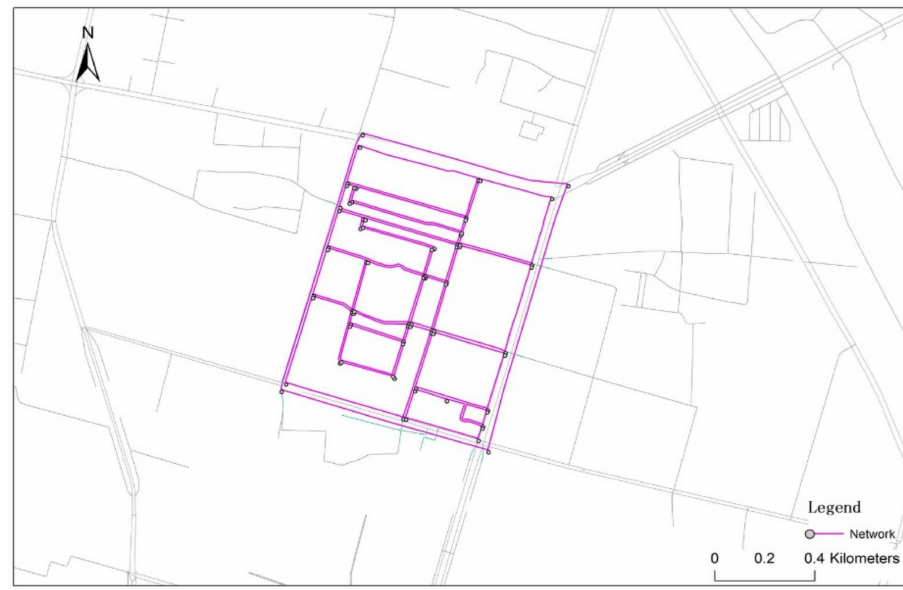
Figure 2. The road network for the study area.